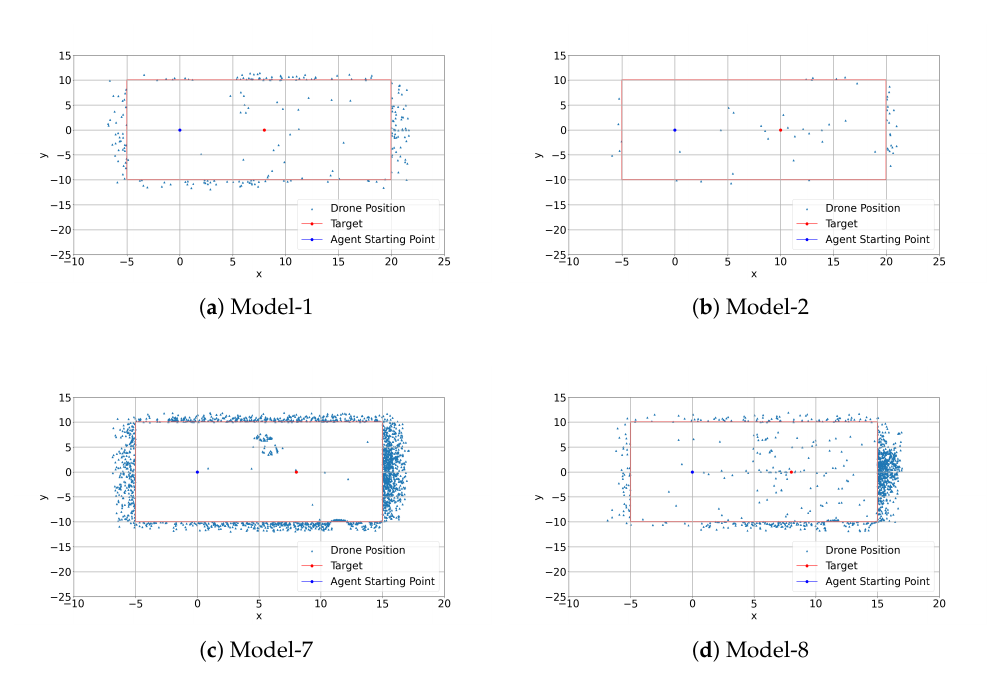
Figure 10. Training Results.